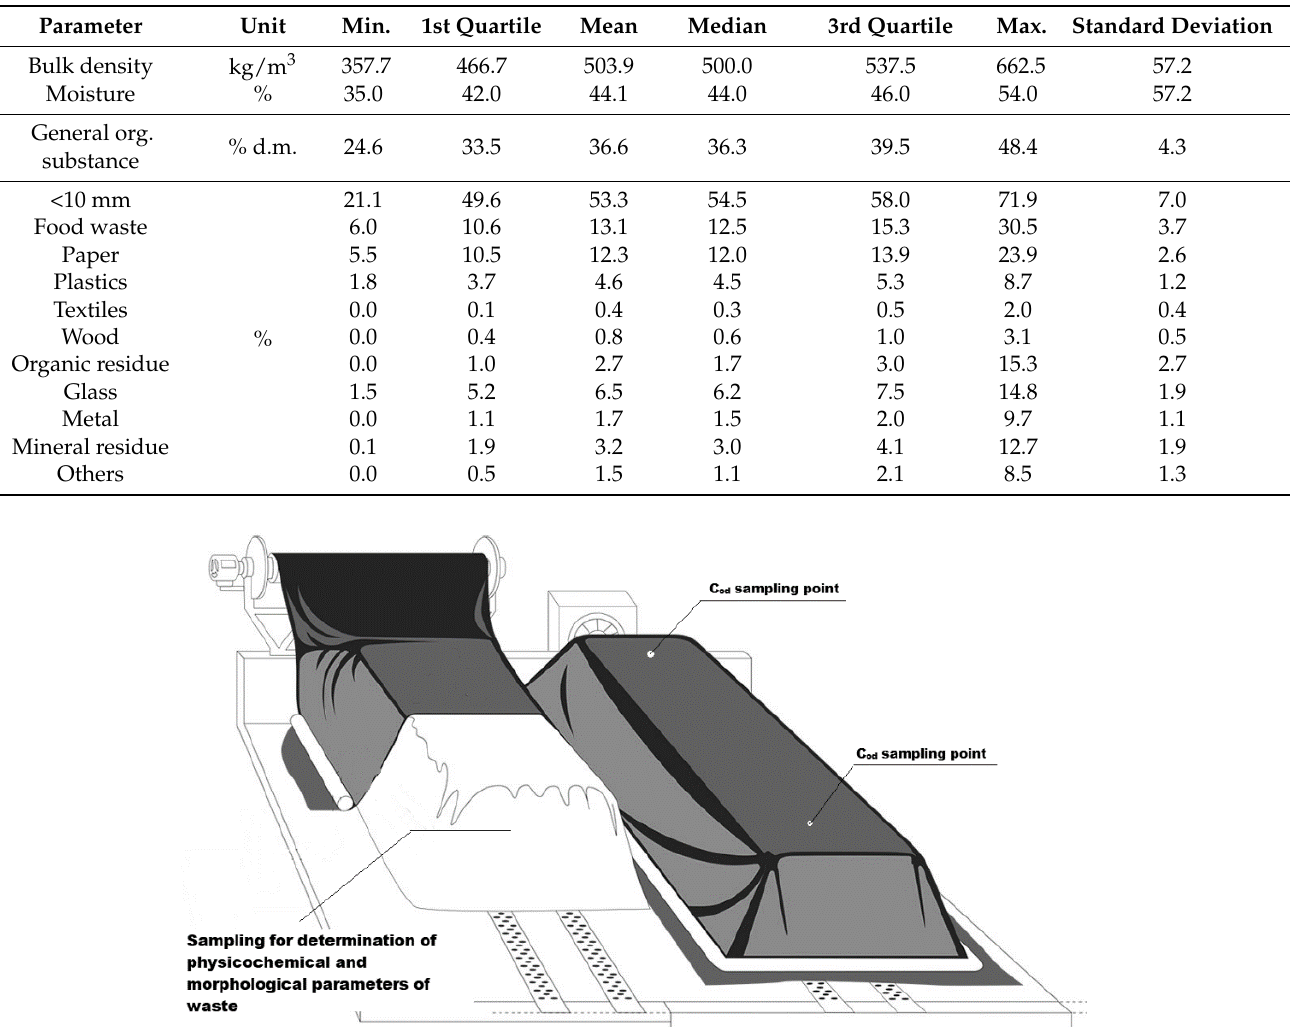
Table 1. Physicochemical parameters and morphological composition of waste deposited on the biostabilization square in 2015–2017.